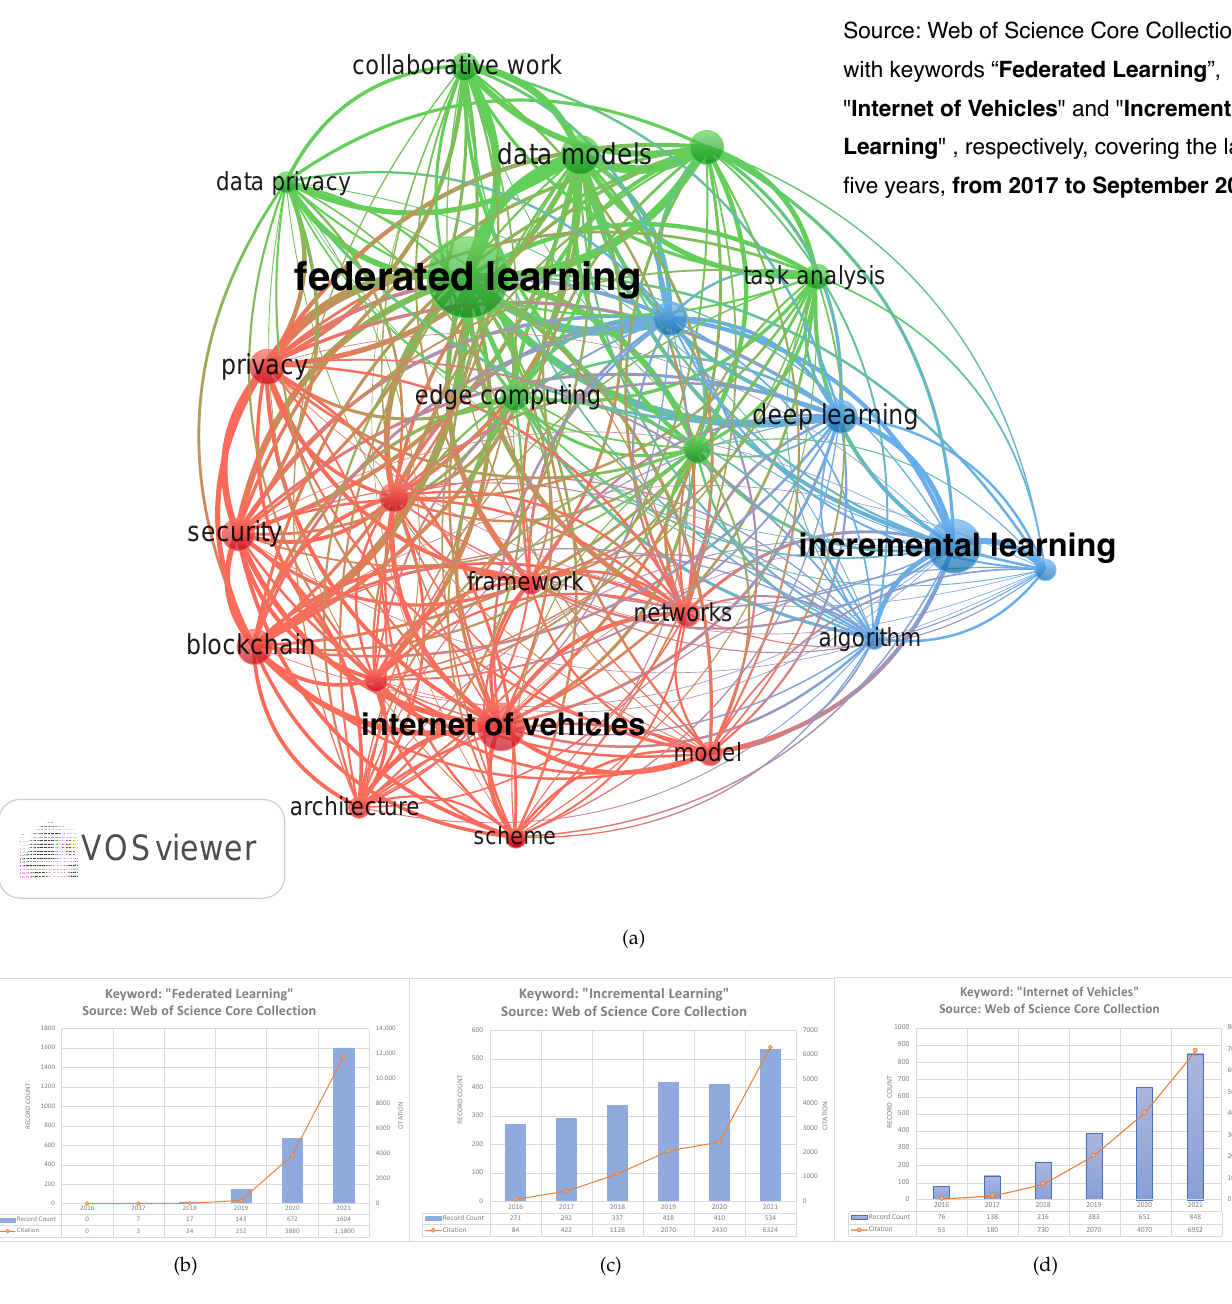
Figure 1. The citation relationship between “Federated Learning”, “Incremental Learning” and “Internet of Vehicles”, as well as the number of publications and citations in the last five